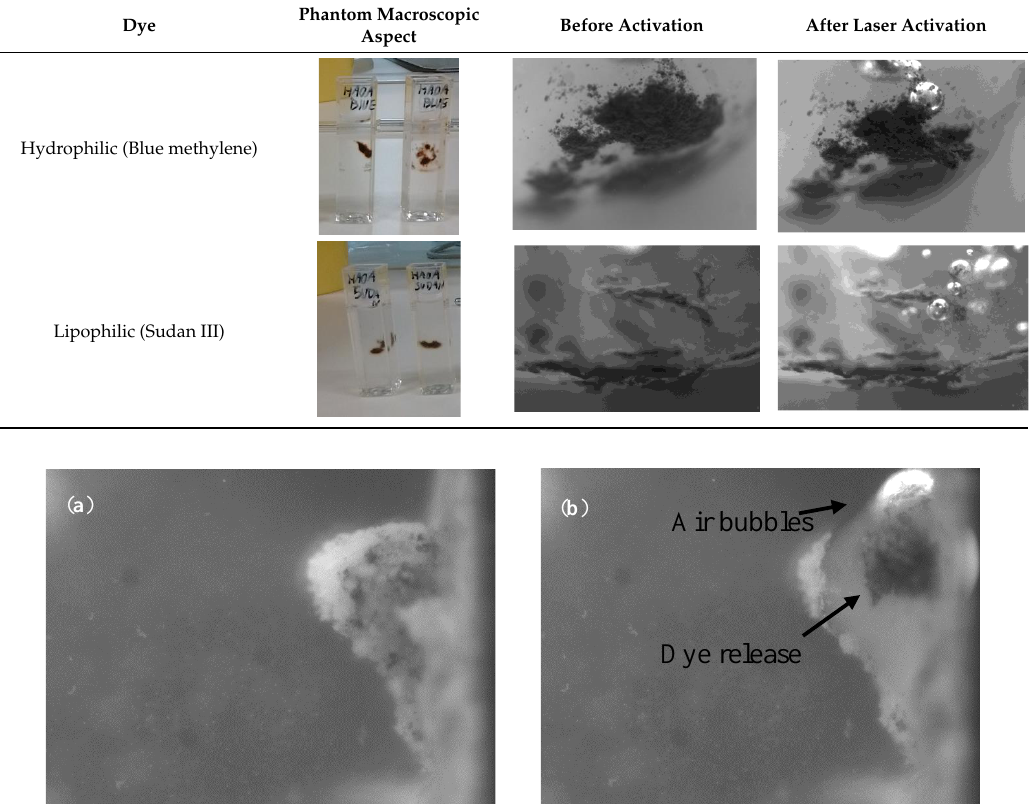
Figure 6. Results of thermal activation of HAOA-coated GNPs conjugated with methylene blue. ( a ) Before activation and ( b ) after activation where air bubbles and dye release are present (see more details in the video).